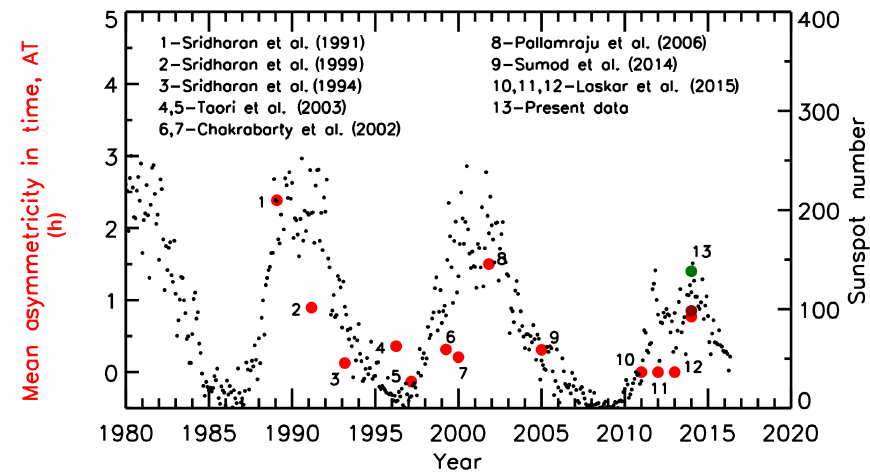
Figure 8. Variation of mean asymmetricity in time (AT) at OI 630.0nm emissions in different years as obtained from the published literature is shown. The monthly averaged sunspot number is also plotted. A striking similarity between them indicates that the equatorial electric field has a direct role in the observed diurnal behaviour of the neutral optical dayglow emission